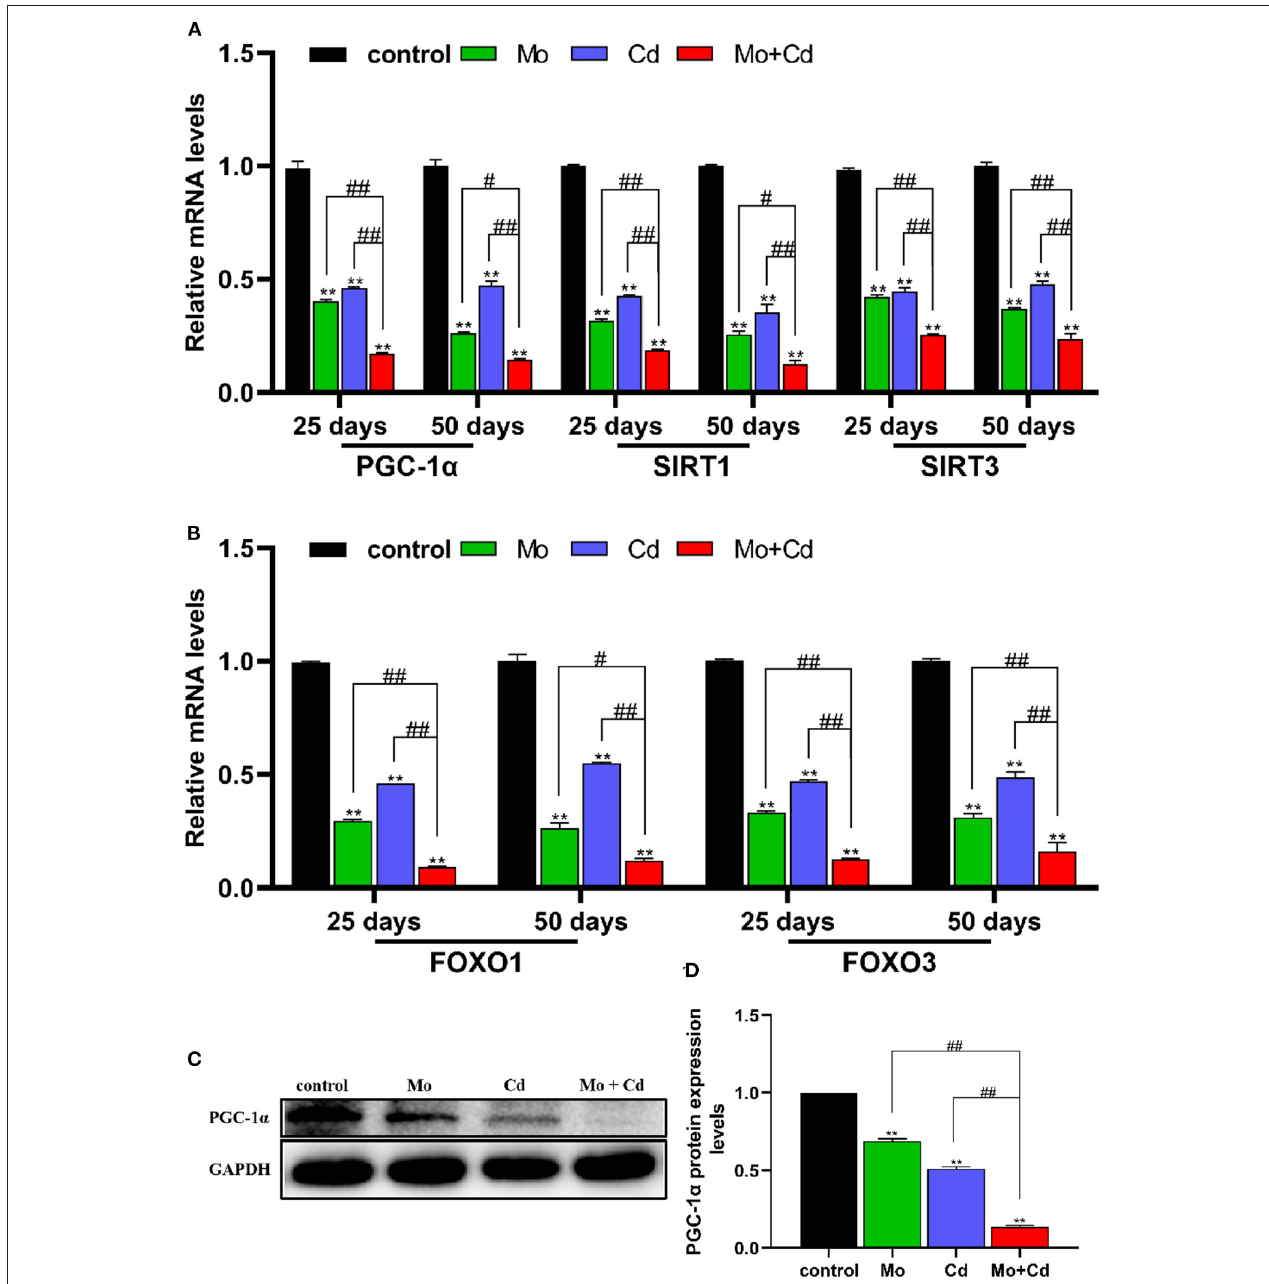
FIGURE 5 | Mo or/and Cd exposure regulated mitochondrial biogenesis. (A,B) The mRNA levels of PGC-1 α , SIRT1, SIRT3, FOXO1 and FOXO3. (C) The western blot results of PGC-1 α . (D) The quantification of PGC-1 α protein levels. Data are expressed as means ± SD ( n = 6). “*” indicates significant difference compared to the corresponding control (* P < 0.05, ** P < 0.01). “#” indicates statistically significant difference between corresponding groups ( # P < 0.05, ## P <